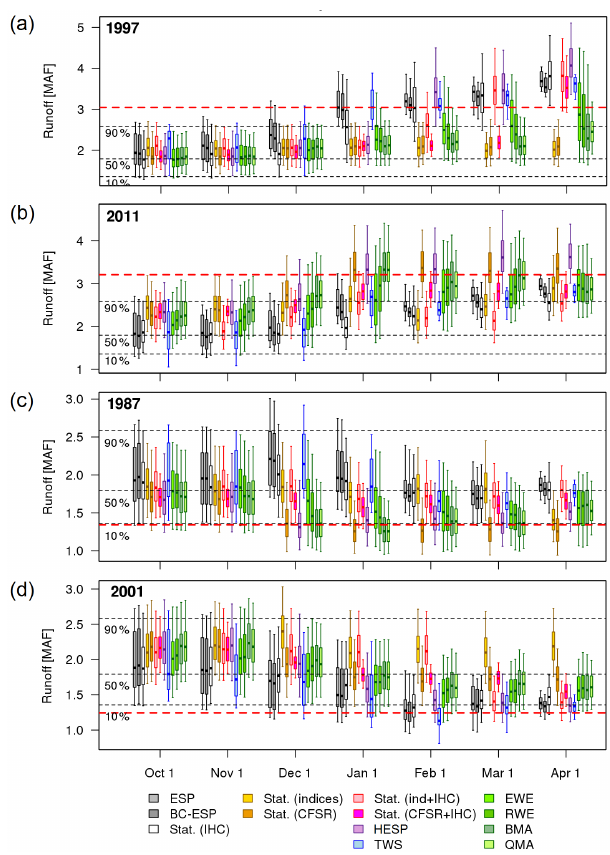
Figure 12. April–July water supply forecasts obtained at the Hun- gry Horse reservoir (HHWM8) with different methods for two wet years – (a) 1997 and (b) 2011 – and two dry years – (c) 1987 and (d) 2001. The red dashed line represents the observed flow, while black dashed lines represent 10, 50, and 90% flows from ob- served climatology, and boxplots show the 10th, 30th, 50th, 70th, and 90th hindcast